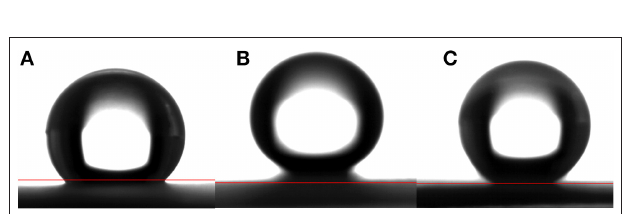
FIGURE 3 | The water contact angle on the ZnO nanorod arrays with different reaction time (A) 2h, (B) 4h, and (C)